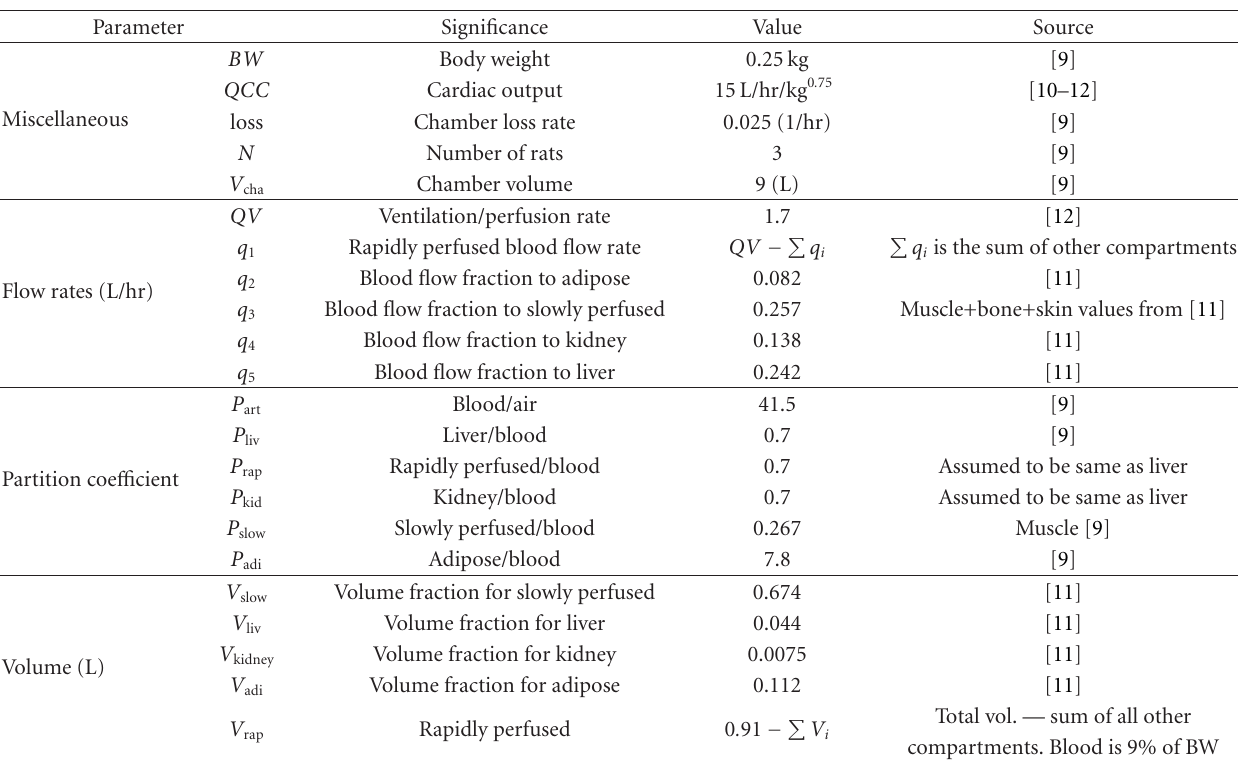
Table 1: Parameters for adult Fisher 344 rats and corresponding significance in the PBPK model. (Note: partition coe ffi cients are unitless